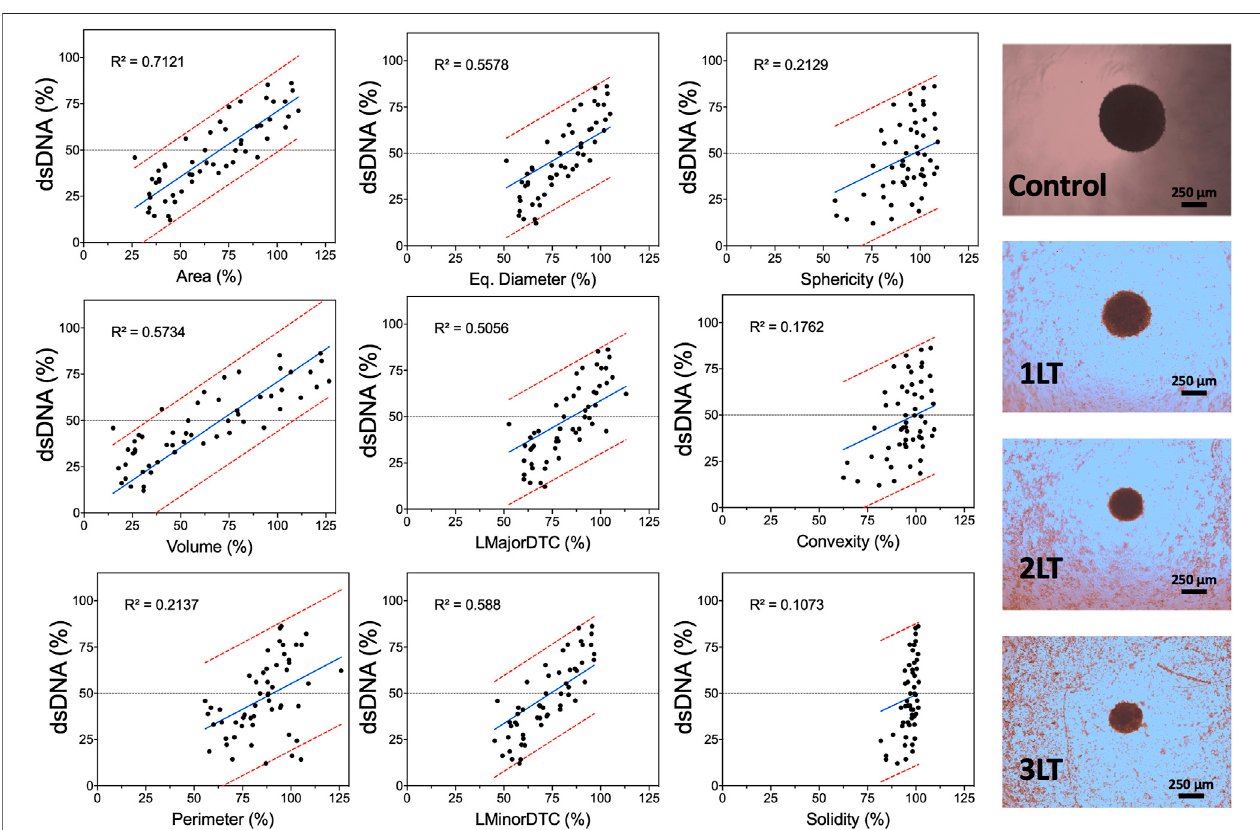
FIGURE6| Morphometricparameterscanbe used topredict PDT-induceddamage inspheroids. Acquiredparametersshow varyingdegrees oflinearcorrelation with LDH release based on control spheroids at the same time point (24 h after light activation). Each dot represents a single spheroid after PDT with PpIX or PpIX-CD. The regressionlineisshown inblue,and the95%prediction intervals areshownin red.Wide fi eldimagesofspheroidsafter differentcombinations ofPDTtreatmentsare shown on the right (PpIX, 10 µg/ml). ( N (cid:1) 3, n (cid:1) 6).